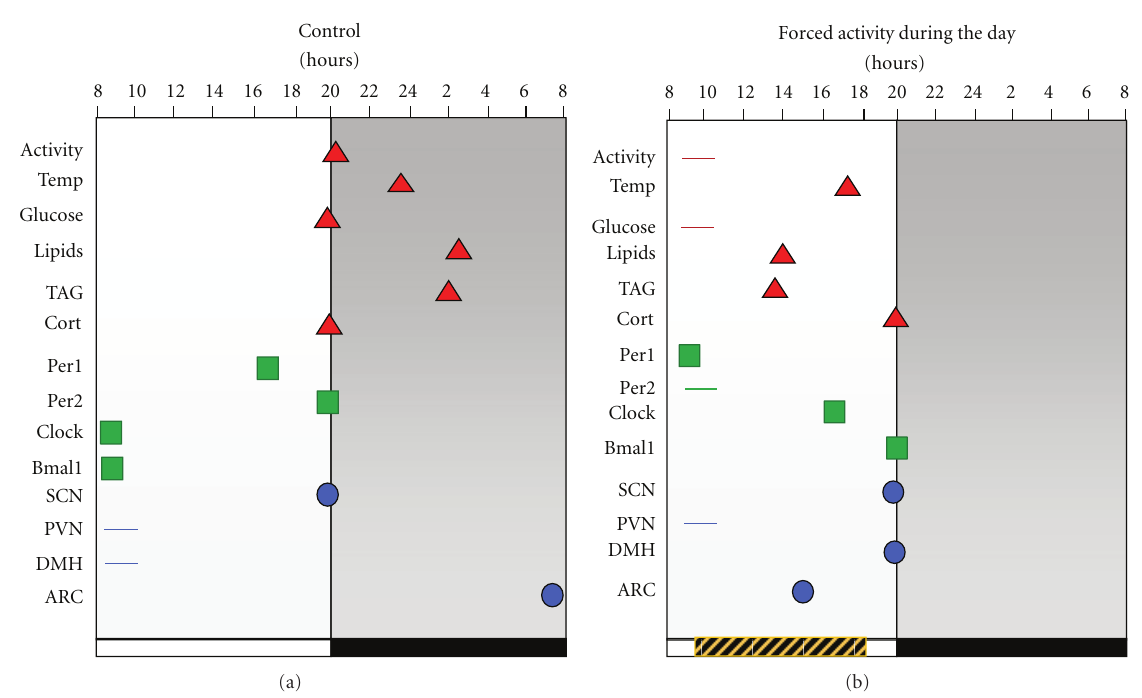
Figure 1: Moments of peak activity for physiological variables in rats living undisturbed in control ad libitum conditions (a) and rats exposed for 4 weeks to 8 h forced activity during the rest phase (b). Symbols represent the moments of maximal expression of each variable along the 24h cycle. Data were obtained from three previous reports [60, 61, 67] and peak values were statistically di ff erent from low values of the same group according to a one way ANOVA ( P < 0 . 05). Day and night are represented by white and black horizontal bars below the graphs and the time in the activity drums is represented by the grey striped horizontal bar. The “ y ” axis represents variables measured in metabolism (triangles) in the liver (squares) and in the brain (circles). Horizontal lines indicate loss of rhythmicity and therefore no significant peak value for that variable and condition. The daily scheduled activity induced shifts of several variables and led to circadian misalignment. Abbreviations: Temp: core temperature; TAG: triglycerides; Cort: corticosterone; Per1: clock gene period 1; Per2: clock gene period 2; SCN: suprachiasmatic nucleus; PVN: paraventricular nucleus in the hypothalamus; DMH: dorsomedial nucleus in the hypothalamus; ARC: arcuate